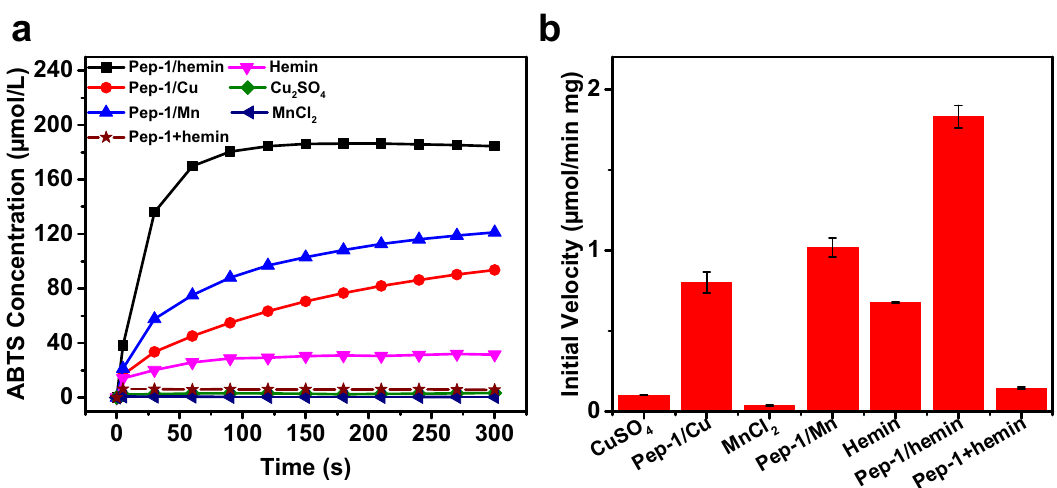
Fig. 2 Peroxidase mimetic activity of Pep-1/hemin, its constituent components, and its metal substitutes. a Change in ABTS concentration by H 2 O 2 over time in the presence of Pep-1/hemin complex, simple mixing of Pep-1 nanotubes and hemin, Pep-1/Cu complex, Pep-1/Mn complex, free hemin, CuSO 4 salt, and MnCl 2 salt. b Initial velocities of reactions catalyzed by CuSO 4 , Pep-1/Cu , MnCl 2 , Pep-1/Mn , hemin, Pep-1/hemin , and simple mixing of Pep-1 nanotubes and hemin (namely Pep-1 + hemin ). The error bar represents the standard deviation of three